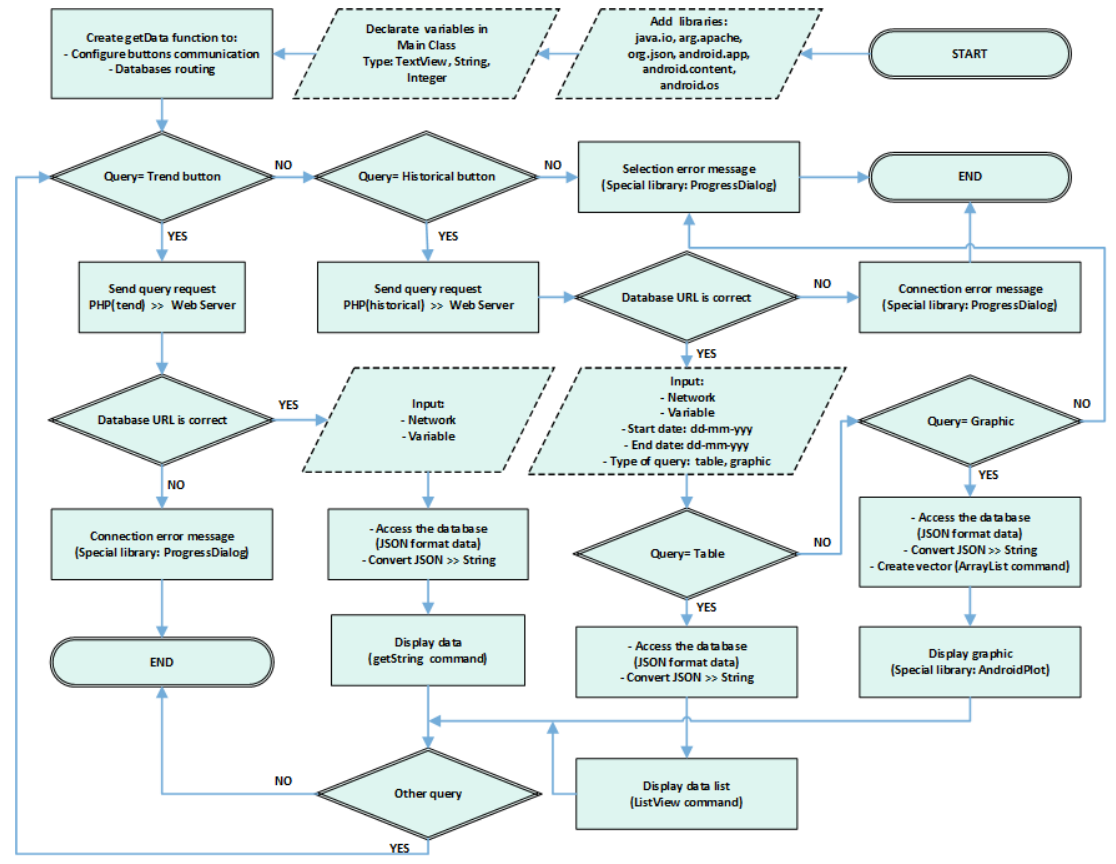
Figure A4. Flowchart of logic programming mobile